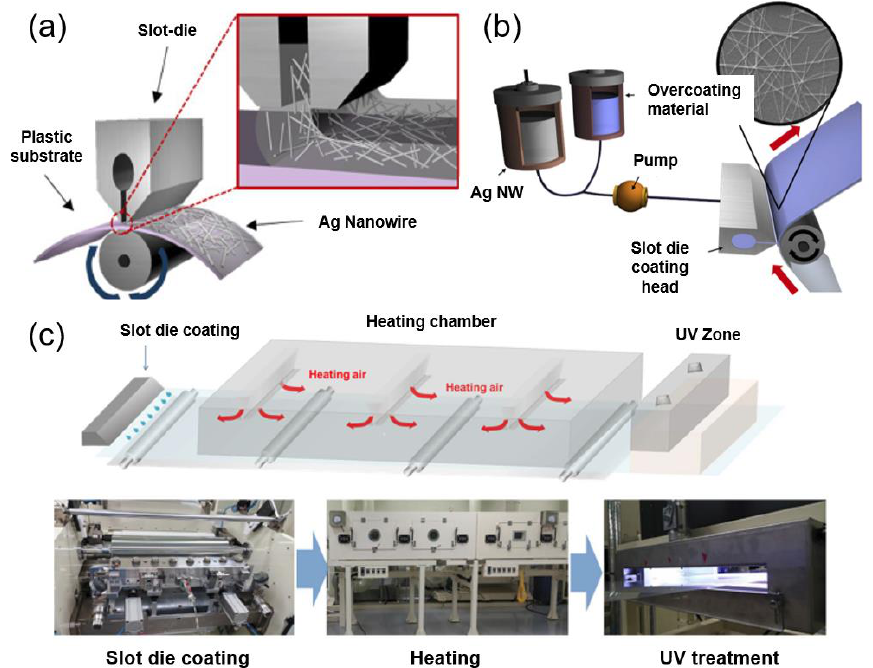
Figure 7. ( a ) Schematic of slot-die coating of Ag NW network [22]. ( b ) Schematic of slot-die coating of Ag NWs and the over-coating layer. ( c ) Schematic of continuous R2R slot-die coating system required to coat Ag NWs and over-coating layer on the PET substrate [23].